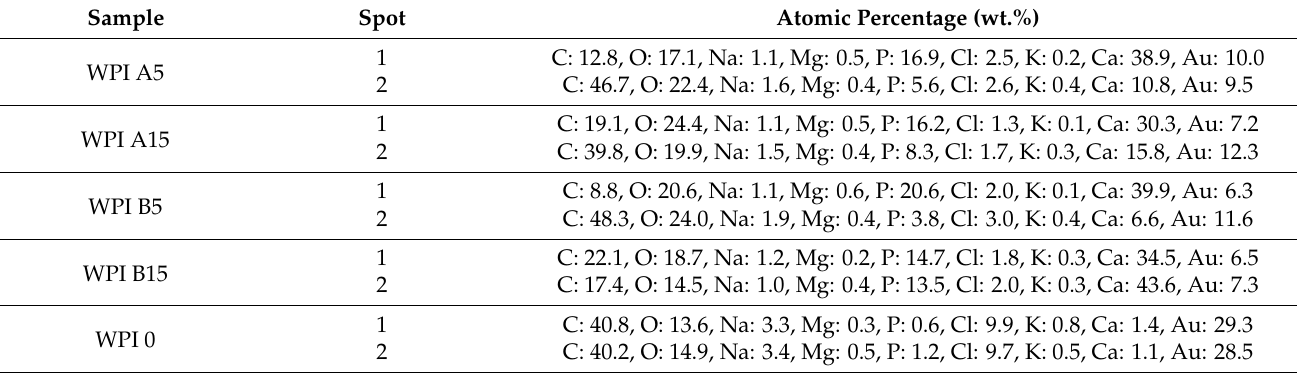
Table 7. Elemental composition of hydrogels after incubation in SBF. Sample Spot Atomic Percentage